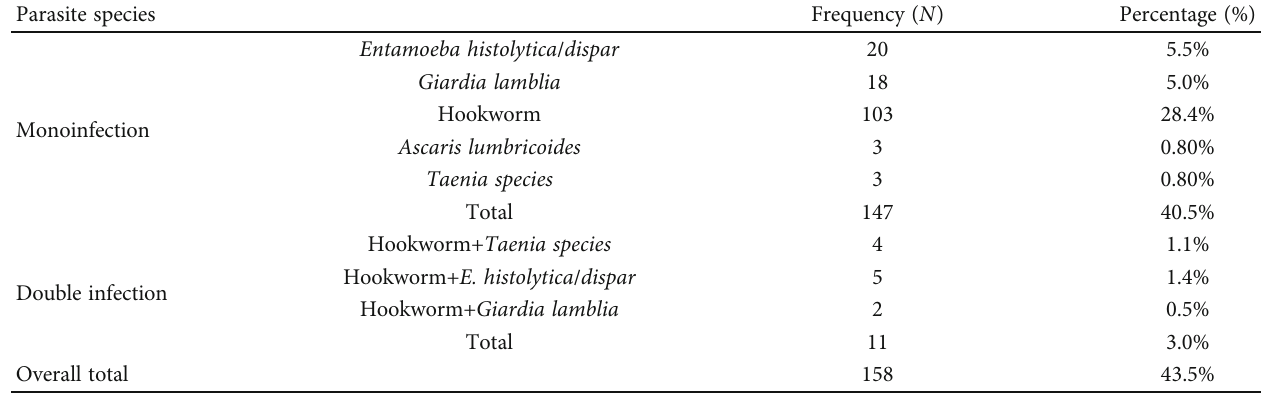
Table 2: Prevalence of intestinal parasites among pregnant women in Debre Elias district, Northwest Ethiopia, March 2021 to July 2021. Parasite species